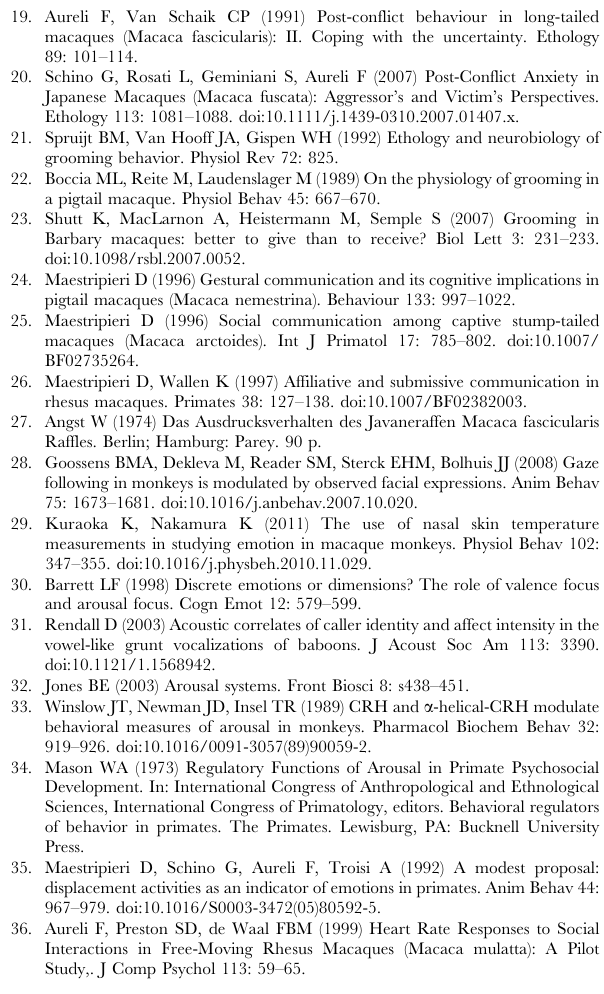
Table S4 Interaction distances for social behaviors. Table S5 Effect of social behaviors on arousal, anxiety and satisfaction